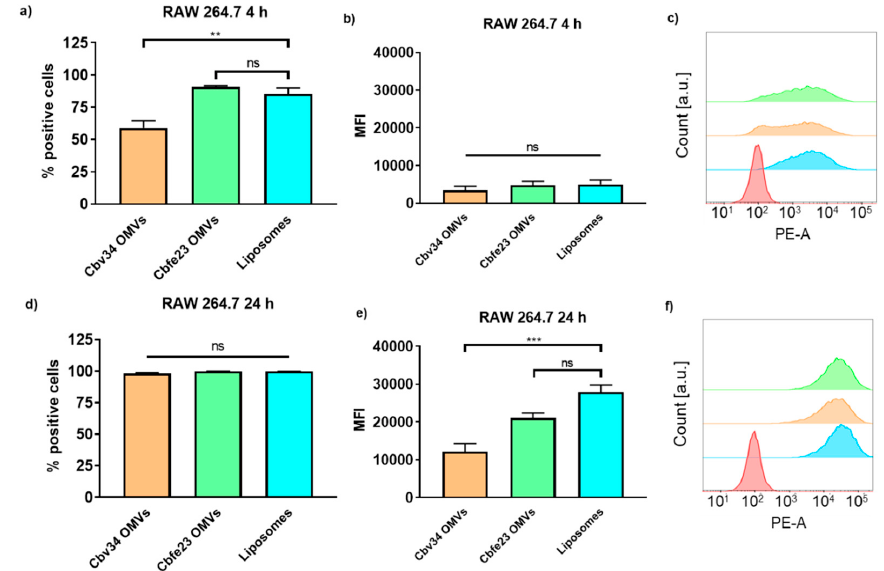
Figure 7. Interaction and uptake of OMVs and liposomes after incubation with RAW 264.7 cells. The percentage of positive cells (which interacted with DiI-labelled OMVs) after ( a ) 4 h and ( d ) 24 h of incubation. The MFI after ( b ) 4 h and ( e ) 24 h of incubation. Representative histograms of Cbfe23 OMVs (green), Cbv34 OMVs (orange), liposomes (blue) and untreated control (red) after ( c ) 4 h and ( f ) 24 h of incubation. Mean ± SEM, n = 3. ** p < 0.005, *** p < 0.0005 and ns = not significant. As for the localization of the particles within the cells, we observed little fluorescence signal coming from the particles after 4 h of incubation with A549 (Figure S7), and a higher fluorescence of Cbfe23 OMVs when incubated with RAW 264.7 cells for 4 h (Figure S8), when compared to the Cbv34 OMVs. Even though we saw DiI-stained Cbv34 and Cbfe23 OMVs within the cells, we did not observe colocalization with the cytoskeleton at any investigated time point (Figure 8). We noticed a removal of OMVs by PBS washing during the staining process, which may indicate that they are mostly bound onto the cell surface. When the cells were washed once with PBS and fixed, we observed a high number of fluorescent particles in A549 cells (Figures S9 and S10).